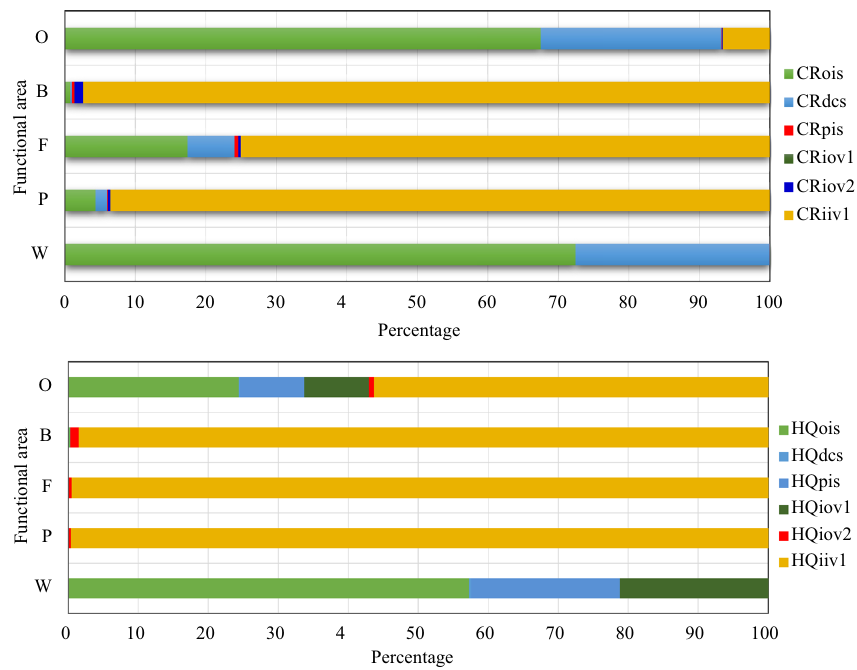
Figure 5: The contribution rate of TCR and HI from di ff erent exposure pathways for functional areas.